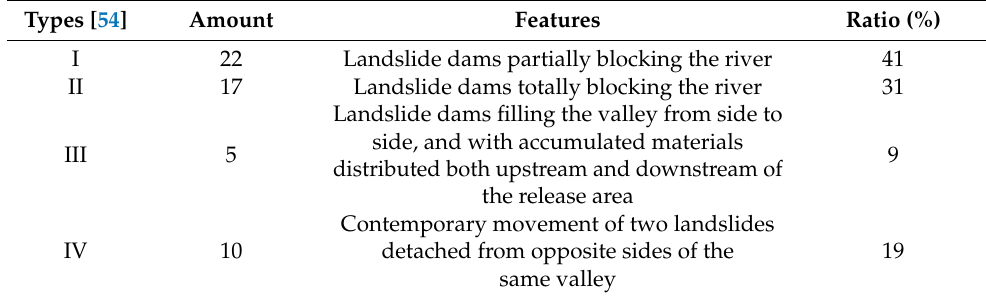
Table 3. Geomorphometric loess landslide dam